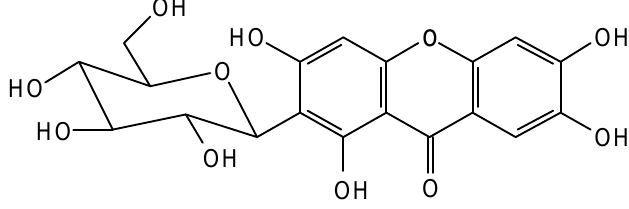
Figure 2. Structure of Mi1 , mangiferin, isolated from M. indica